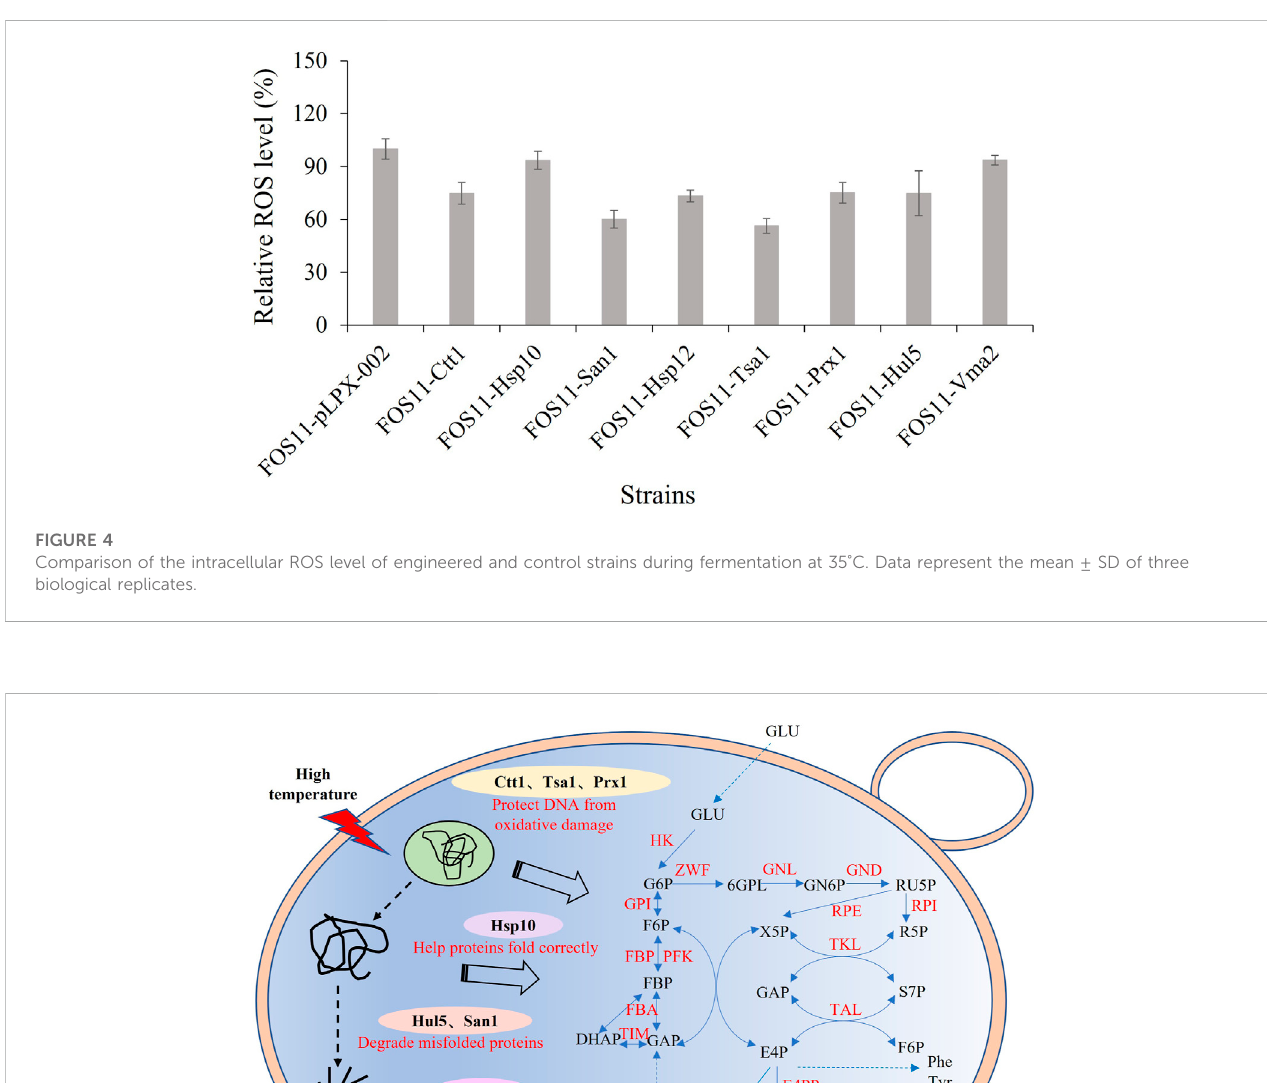
Frontiers in Bioengineering and